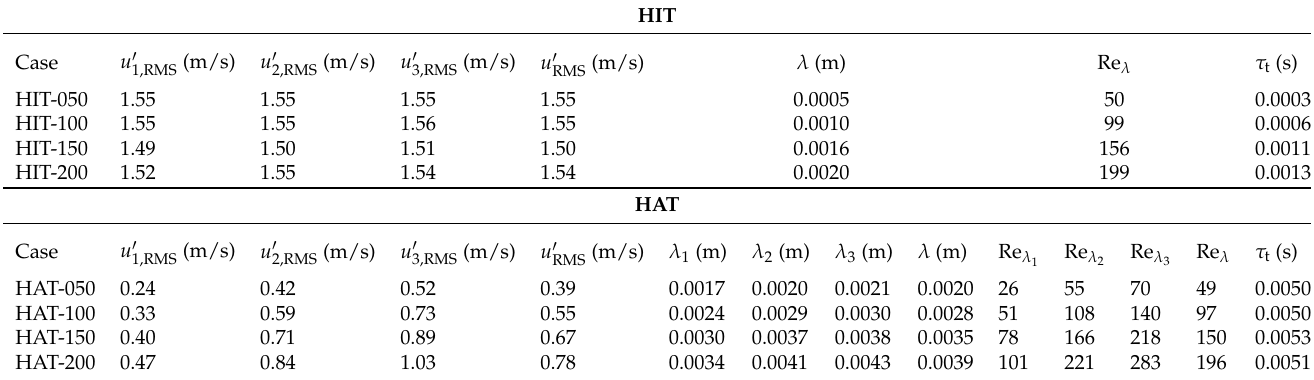
Table 1. Details of the